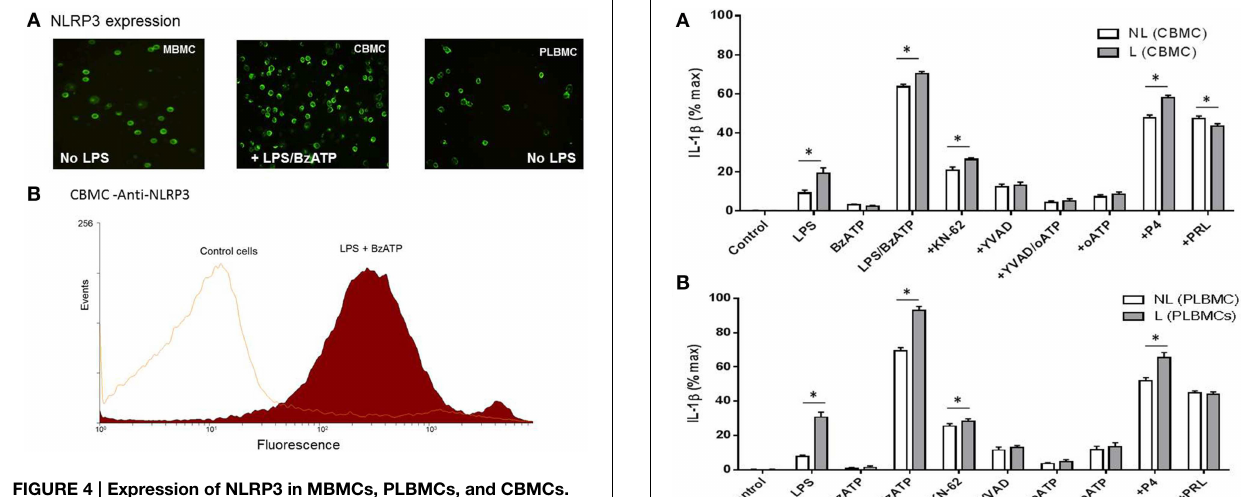
FIGURE 4 | Expression of NLRP3 in MBMCs, PLBMCs, and CBMCs. (A) Expression of P2X 7 was detected by immunofluorescence in MBMCs (LH panel), CBMCs (middle panel) and PLBMCs (right hand panel) with CBMCs requiring prior incubation with LPS + BzATP before NLRP3 was detectable. (B) Flow cytometry demonstrated that costimulation with LPS + BzATP resulted in 92.4% of CBMCs showing NLRP3 expression as seen in the single parameter histogram.